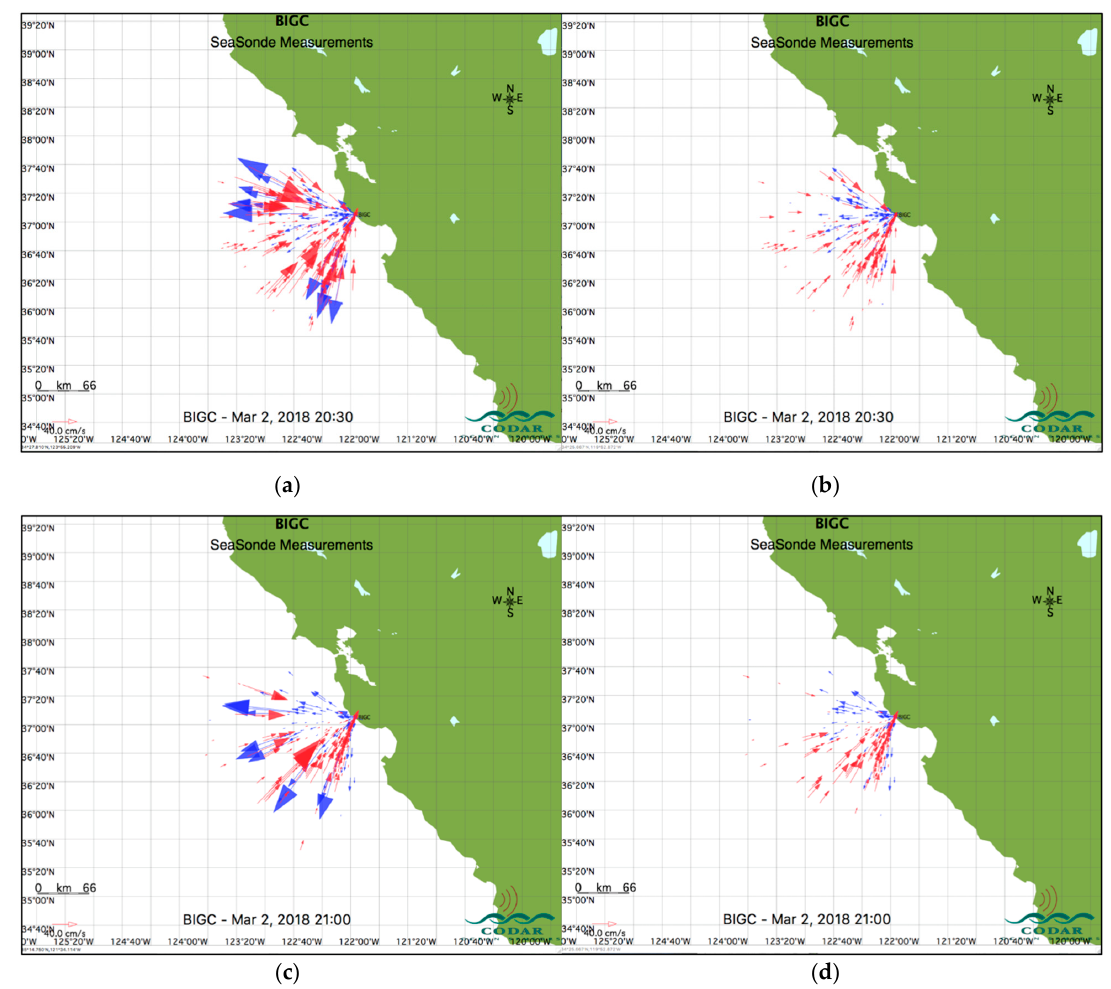
Figure 7. Comparison of current velocity maps obtained with and without QC at Big Creek, California. Radar transmit frequency 4.5 MHz. The threshold S lim was set to 8.0. 2 March, 2018, 8:30 p.m.: ( a ) without QC, 𝑅𝑀𝑆 𝑎𝑣 =858.6 ( b ) with QC, 𝑅𝑀𝑆 𝑎𝑣 =1.9. 2 March, 2018, 21:00: ( c ) without QC 𝑅𝑀𝑆 𝑎𝑣 = 414.4, ( d ) with QC 𝑅𝑀𝑆 𝑎𝑣 = 1.6.